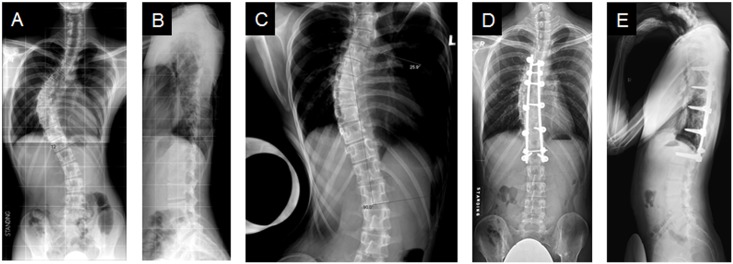
Saved distal fusion levels.A case where one level was saved. (A) A male AIS patient with a preoperative standing coronal Cobb angle of 61.6 degrees from T5-T12. (B) His standing sagittal Cobb angle from T5-T12 was 5.1 degrees. (C) Fulcrum bending radiograph demonstrated a curve of 31.3 degrees. Last follow-up (D) standing coronal Cobb angle was 26.8 degrees and (E) standing sagittal Cobb angle was 4.5 degrees.